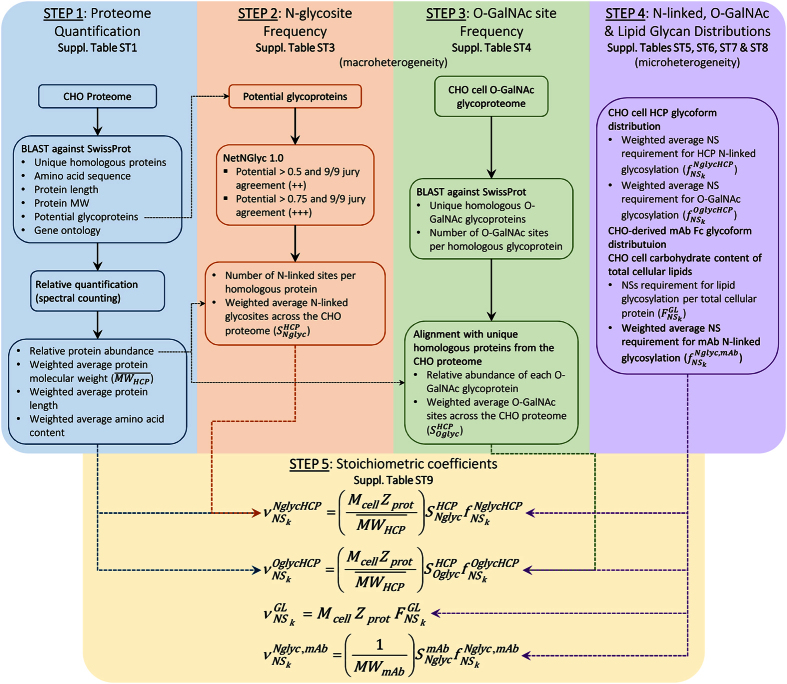
Workflow for the estimation of stoichiometric coefficients for nucleotide sugar demand towards CHO cell and mAb glycosylation.Step 1: the CHO proteome19 was BLASTed28 against the SwissProt database27 to obtain the corresponding confirmed homologous proteins. The length, amino acid sequence, molecular weight, and potential N-linked glycosylation sites for each homologous protein were extracted from the database. Using the protein length and the spectral counts available from literature19, the relative abundance of each homologous protein (Zi) was obtained2930 (Eq. 2). With Zi, the weighted average protein length , molecular weight , and amino acid content were calculated (Eqs 3, 4, 5). Step 2: the amino acid sequences of potentially N-glycosylated homologous proteins were analysed with the NetNGlyc 1.0 server32 to obtain the number of occupied N-linked sites per HCP . The weighted average number of N-linked glycosites across the CHO proteome  was obtained by combining  with Zi (Eq. 6). Step 3: the CHO O-GalNAc glycoproteome21 was BLASTed28 against the SwissProt database27. The obtained list of homologous proteins was aligned with the one from the CHO proteome to obtain the weighted average number of O-GalNAc glycosites across the CHO proteome  (Eq. 7). Step 4: the weighted average monosaccharide composition of CHO HCP N-linked  and O-GalNAc glycans  was obtained from the CHO glycome20 (Fig. 2) using Eqs 8 and 9. The average N-linked glycan monosaccharide composition for a commercial mAb  was also obtained from literature23 (Fig. 2). The demand of NSs towards glycolipid synthesis was obtained from the reported monosaccharide content of CHO cell glycosphingolipids relative to total protein content 22. Step 5: the stoichiometric coefficients for the demand of NSs towards HCP N-linked , O-GalNAc , lipid , and mAb N-linked  glycosylation were calculated using the corresponding equations included at the bottom of the figure using a dry cell weight () of 271pg/cell34, a protein content () of 74.2% (w/w)35, and a mAb molecular weight () of 148,545 g/mol. All data and calculations are presented in Supplementary Tables ST1–ST10.